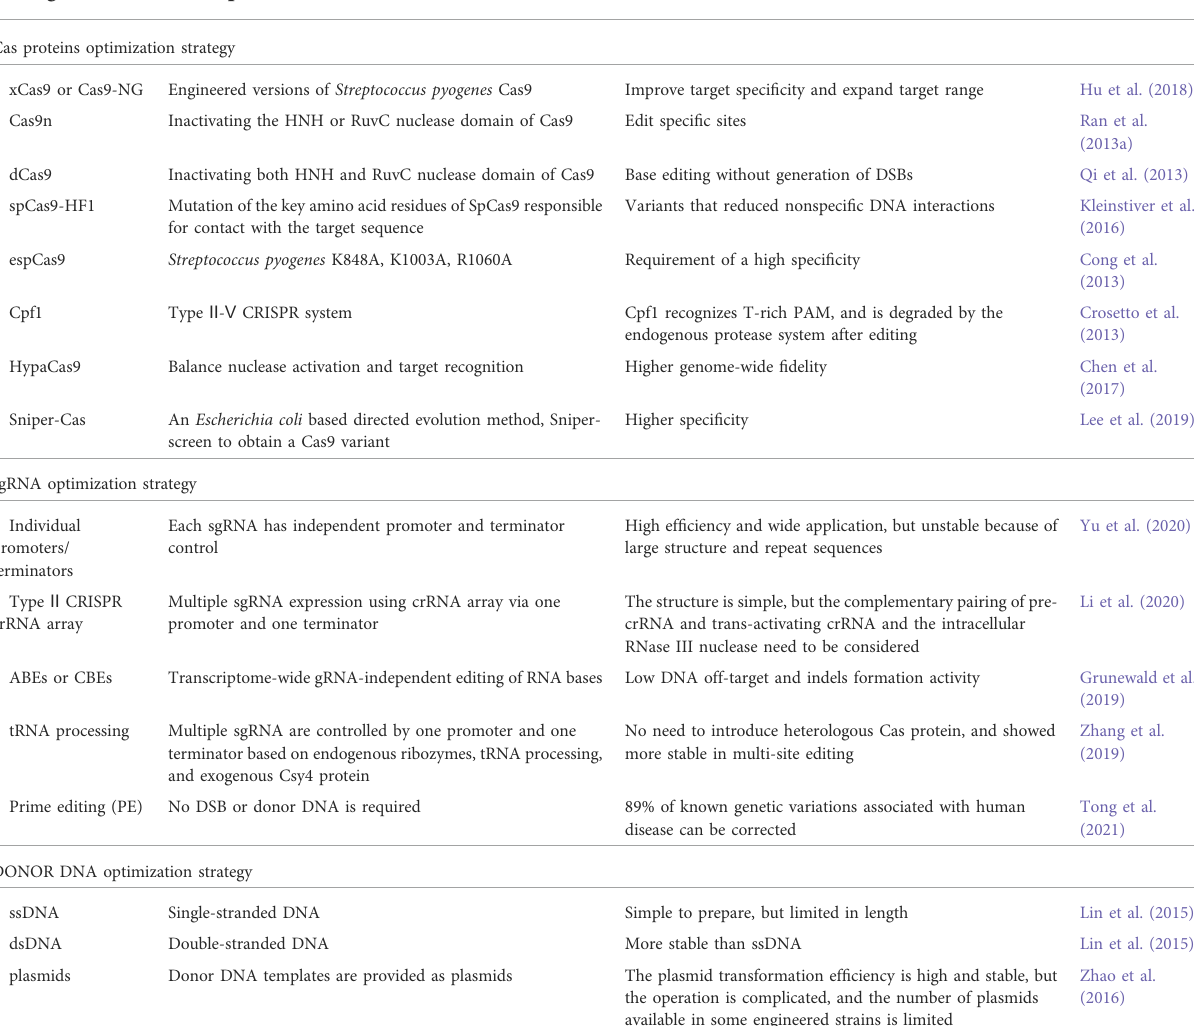
TABLE 1 Improved CRISPR/Cas system involving Cas protein, gRNA and donor